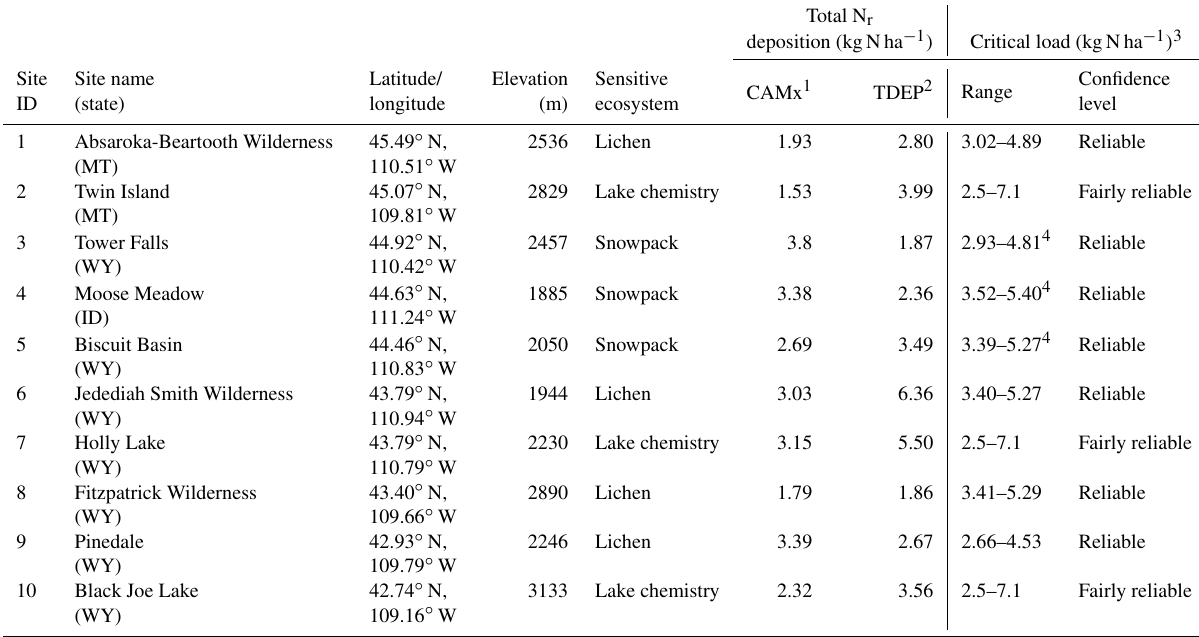
Table 2. Total reactive nitrogen (N r ) deposition and critical loads for receptor points in the Greater Yellowstone Area in